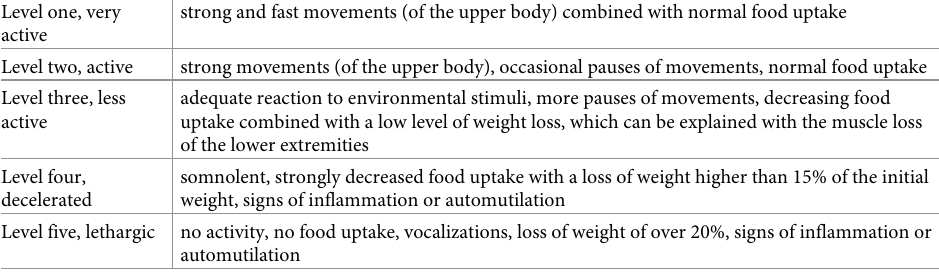
Table 1. Modified score for the evaluation of animals